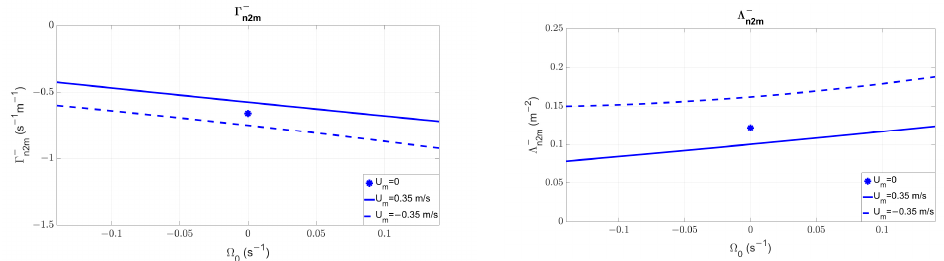
Figure 16. Γ (stream function coefficient) and Λ (surface elevation coefficient) of the n2m-negative interaction component as functions of vorticity.